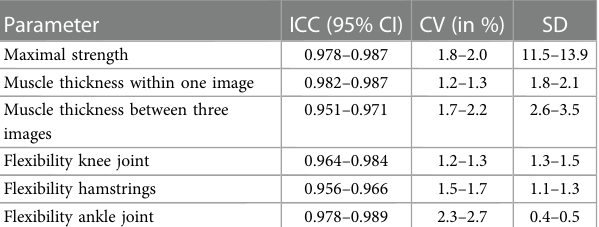
TABLE 2 Reliability of the methods